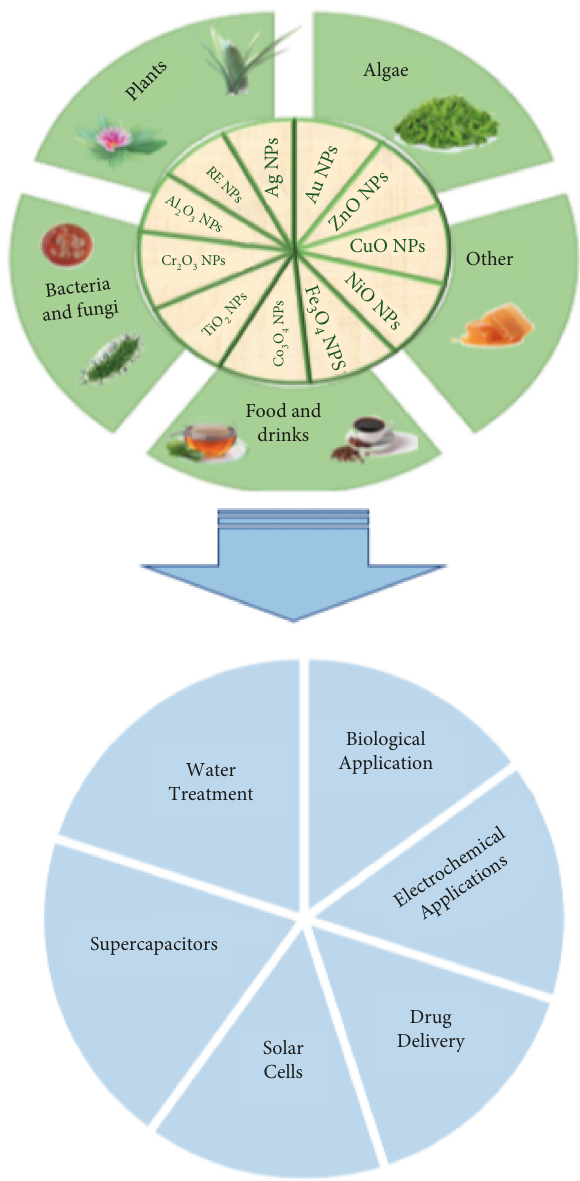
Figure 1: Green methods of nanoparticle synthesis and their